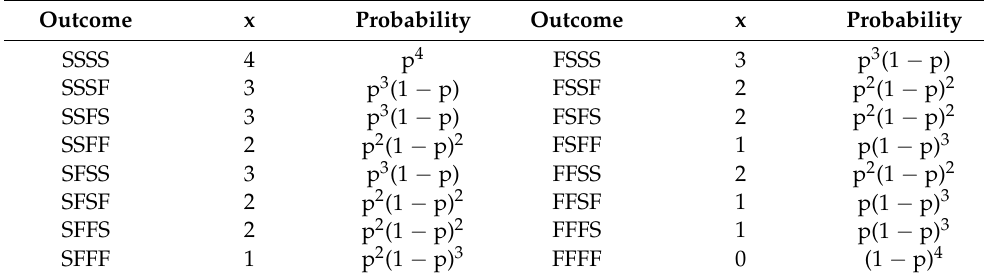
Figure 4. Graphical language element for the binomial with n = 20 and p = 1/2. Table 9. Study of the binomial phenomenon with n = 4, with x being the number of successes (S) obtained (retrieved from [44]).